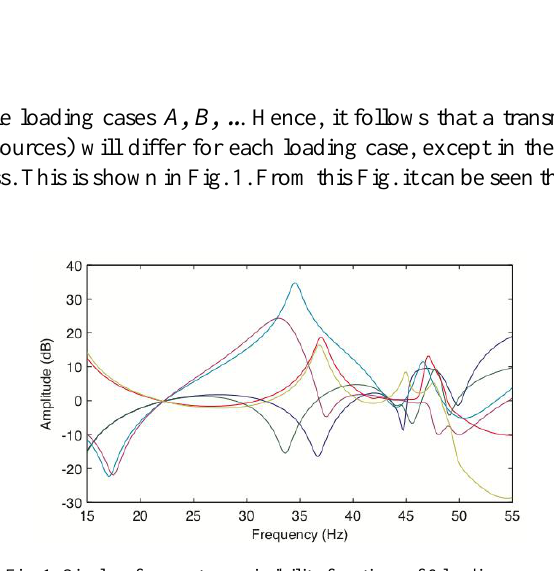
Fig. 1. Single reference transmissibility functions of 6 loading